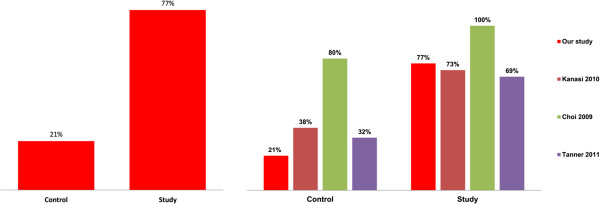
The incidence of S. mutans species divided into groups. On the left, the results obtained in our study; on the right, a comparison of our results with those of other authors.